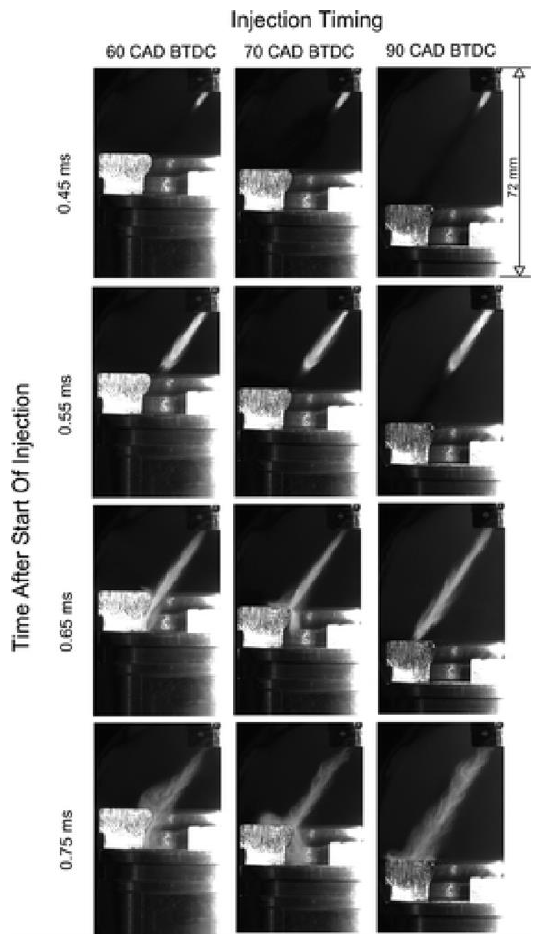
Figure 6. Spray development in a constant-volume vessel: injection quantity = 11.5 mm 3 ; injection pressure = 120 MPa [66]. Reprinted with permission from Energy & Fuels. Copyright 2019 American Chemical Society.